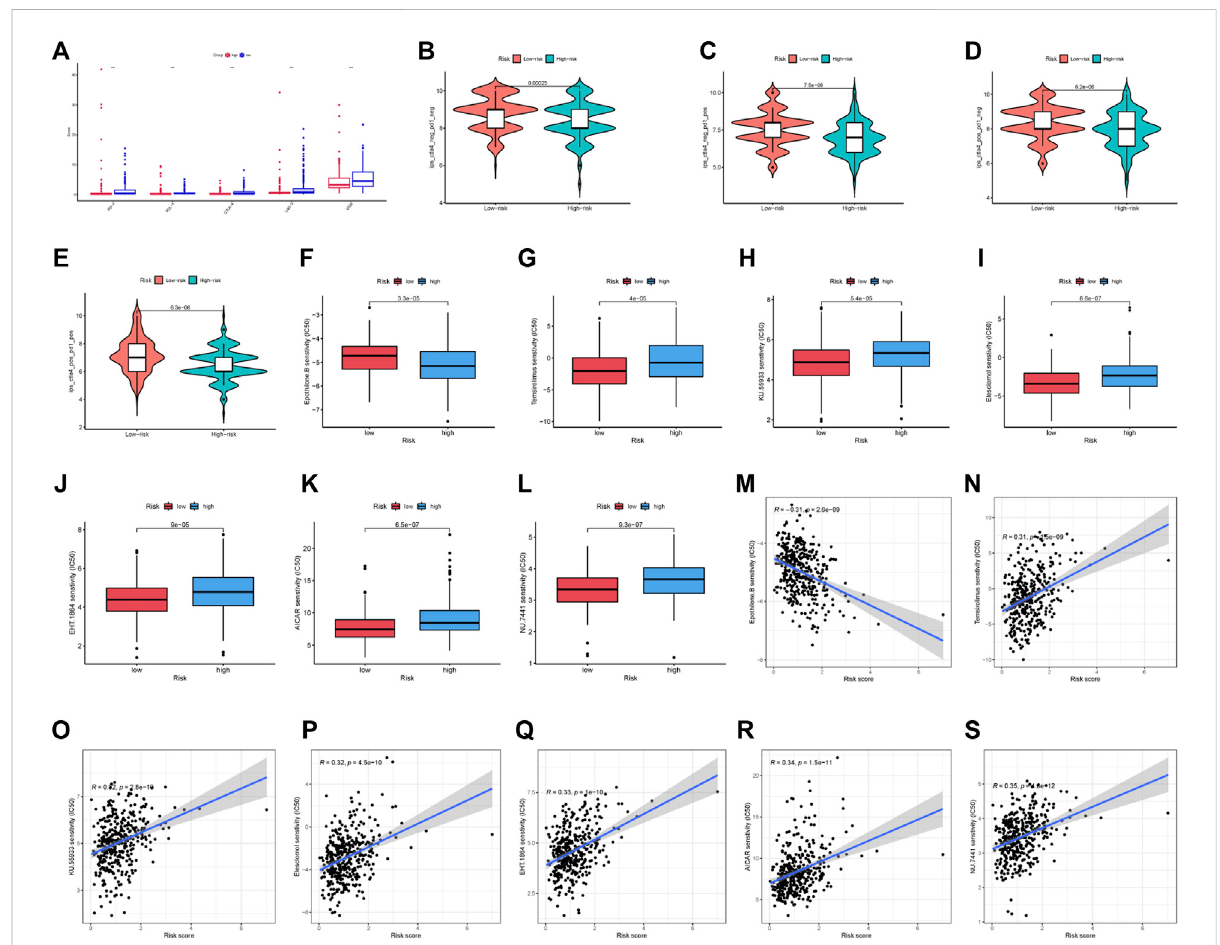
FIGURE 9 Drug prediction and risk strati fi cation correlated with the ef fi cacy of immunotherapy. (A) Five immune checkpoints and their expression in two groups ( p p < 0:05, pp p < 0:01, and ppp p < 0:001). (B) IPS of high-risk and low-risk groups. (C) IPS- PD1 of high-risk and low-risk groups. (D) IPS- CTLA4 of high-risk and low-risk groups. (E) IPS- PD1 + CTLA4 of high-risk and low-risk groups. (F – L) IC50 of seven drugs (epothilone.B, temsirolimus,KU.55933,elesclomol,EHT.1864,AICAR,NU.7441)intwogroups. (M – S) RelationshipbetweenriskscoreandIC50ofsevendrugs (epothilone.B, temsirolimus, KU.55933, elesclomol, EHT. 1864, AICAR,